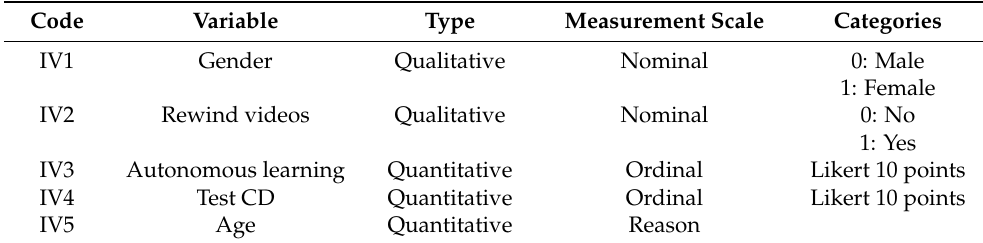
Table 5. Description of